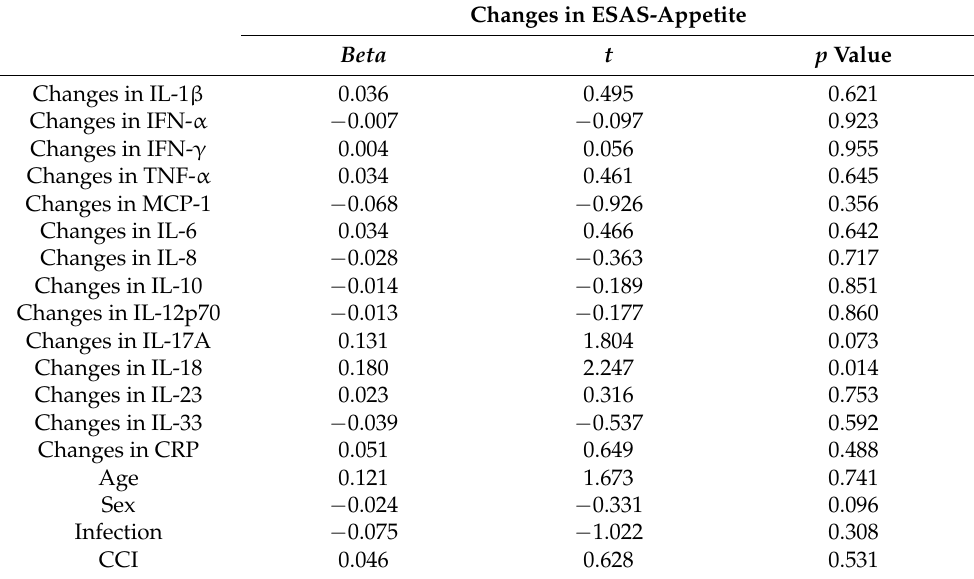
Table 4. Stepwise multiple regression analysis of risk factors associated with changes in ESAS- appetite in total population ( n =